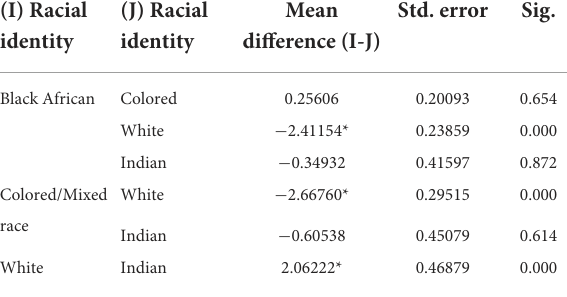
TABLE 3 Socioeconomic status score multiple comparisons by racial identity: Scheffé post-hoc